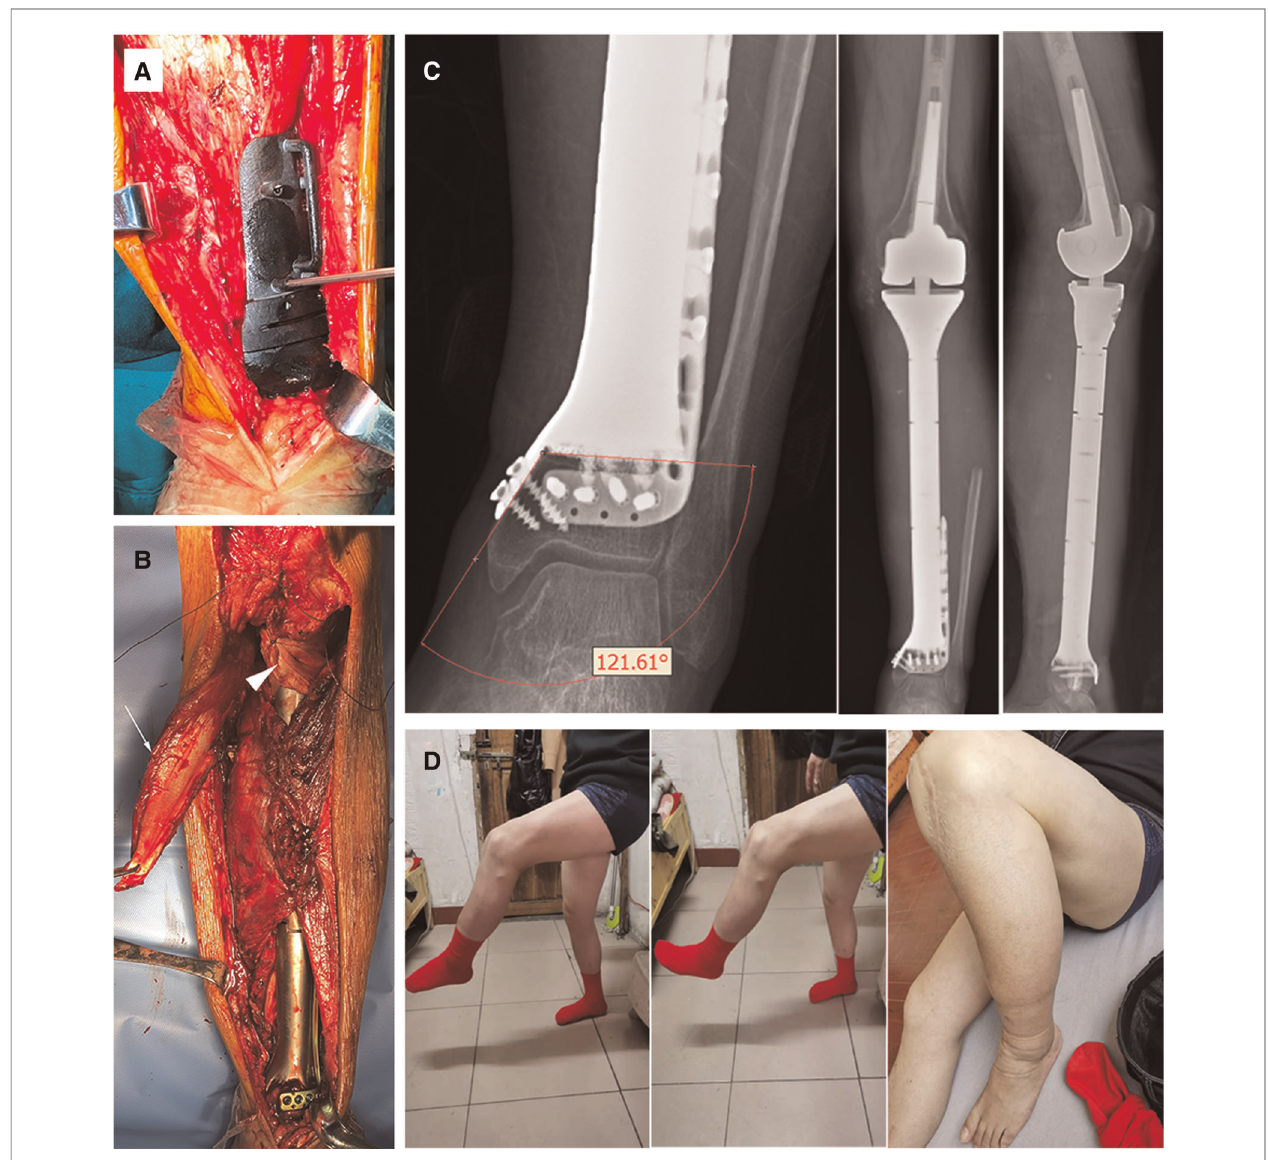
FIGURE 3 | ( A ) Intraoperative utilization of PSG to ensure precise osteotomy; ( B ) The anatomic implantation of the prosthesis. White arrowhead: medial gastrocnemius fl ap; triangular arrowhead: double-surface reconstruction of the knee extension mechanism with an allogenic tendon. ( C ) X-ray of the lower limb 12 months after surgery. The angle of the medial plate was about 121 degrees, which was consistent with the design. No sign of ischemic necrosis or collapse of the distal ultra-small bone fragment was observed. ( D ) The active knee range of motion (ROM) was 0 – 105 degrees and the patient sustained active ankle ROM of dorsal fl exion 0 – 15 degrees, and plantar fl exion 0 – 45 degrees at the latest